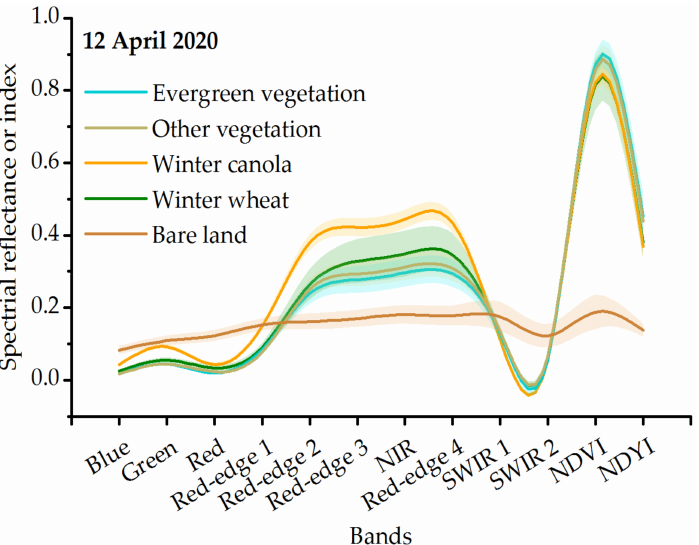
Figure 7. Spectral, NDVI and NDYI profiles from Sentinel-2 imagery on 12 April 2020 in the second study region. Solid lines represent means and shaded areas represent one standard deviation from the